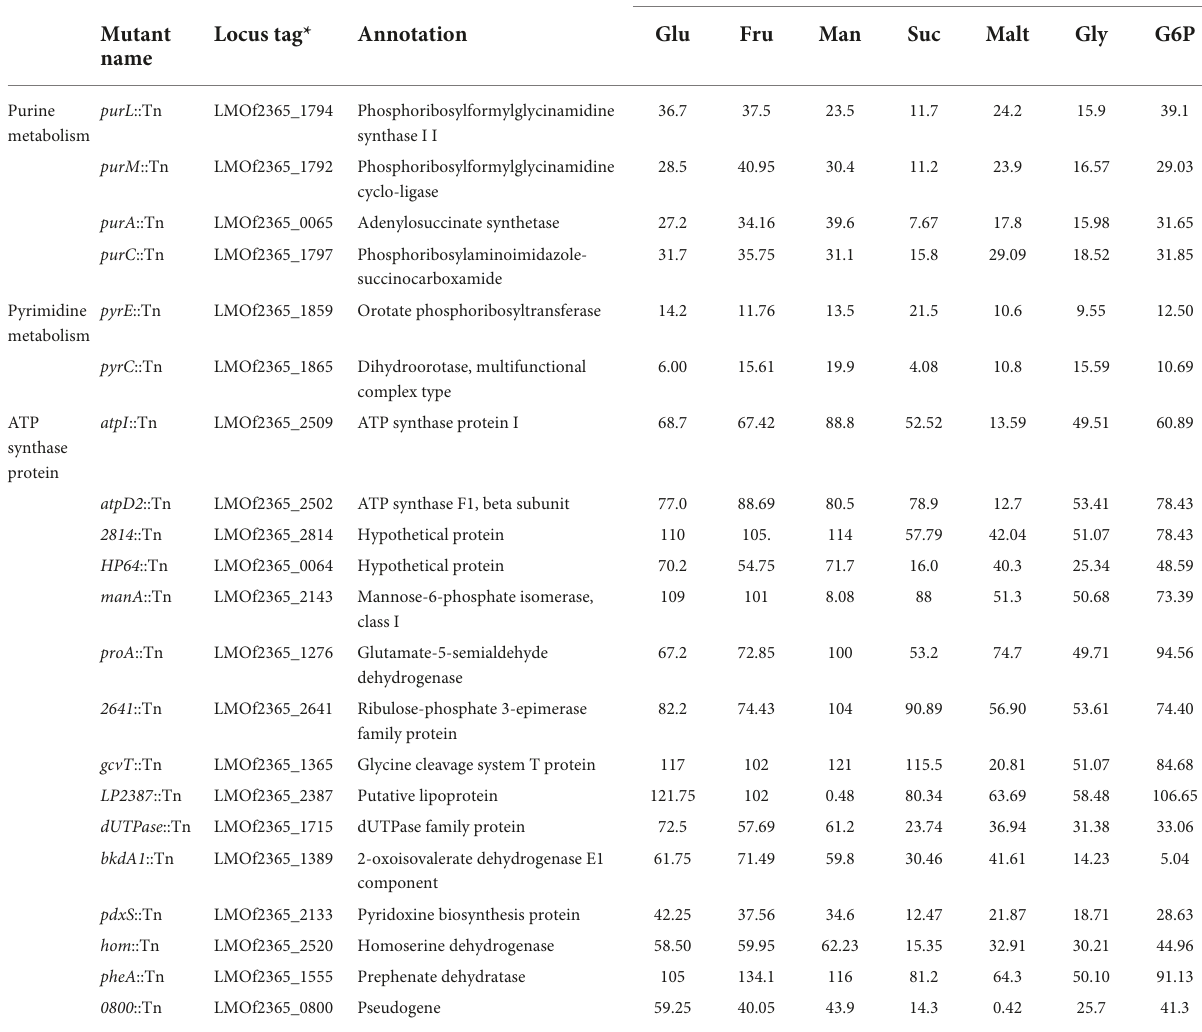
TABLE 2 Tn-insertion mutants with defective growth in MM containing glucose (Glu), fructose (Fru), mannose (Man), sucrose (Suc), maltose (Malt), glycerol (Gly), or glucose 6-phosphate (G6P) as the sole carbon source. Percent growth in MM supplemented with respective carbon source compared to the